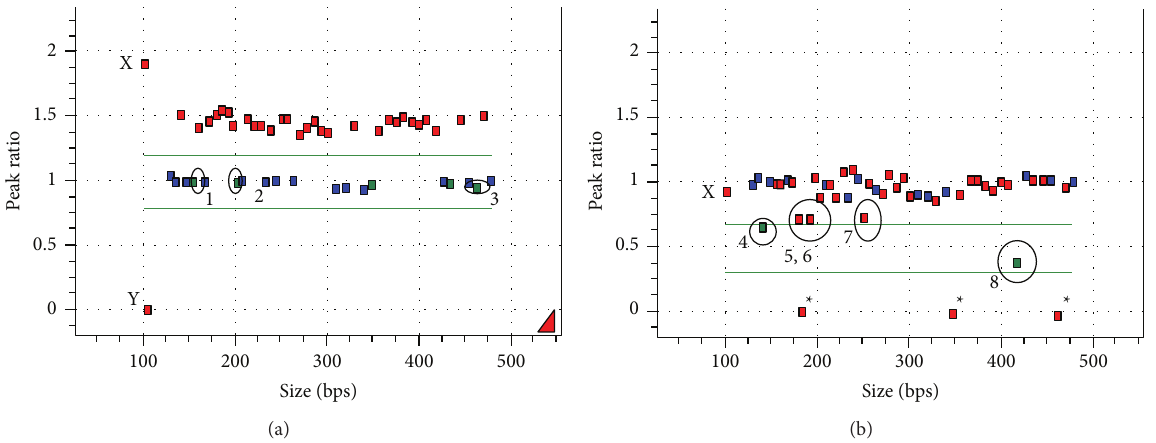
Figure 2: MS-MLPA analysis for determination of 15q11.2 duplication. 𝑥 -axes represent fragment size in bps and 𝑦 -axes represent probe peak ratios. (a) MLPA copy number peak ratio: red = PWS/AS region probes; green = non-PWS/AS region probes. 1 = TUBGCP5; 2 = APBA2; 3 = NIPA1; X (2 copies) and Y (0 copies) chromosome in female patient. (b) MS-MLPA digestion of five HhaI methylation sensitive probes: 4 = SNRPN intron 1; 5 = SNRPN exon 1; 6 = SNRPN intron 1; 7 = SNRPN promoter; 8 = NDN; * = HhaI digestion